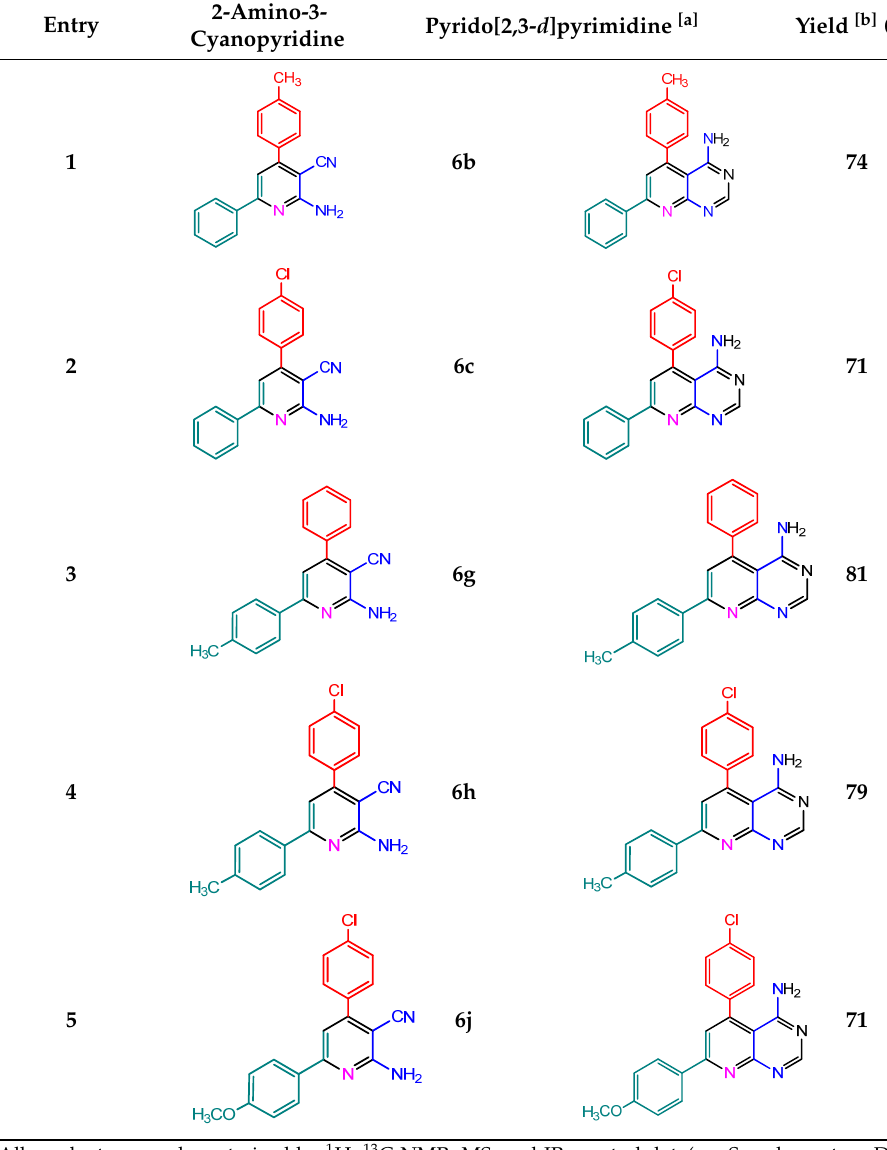
Table 3. Synthesis of pyrido[2,3- d ]pyrimidine derivative 6 .